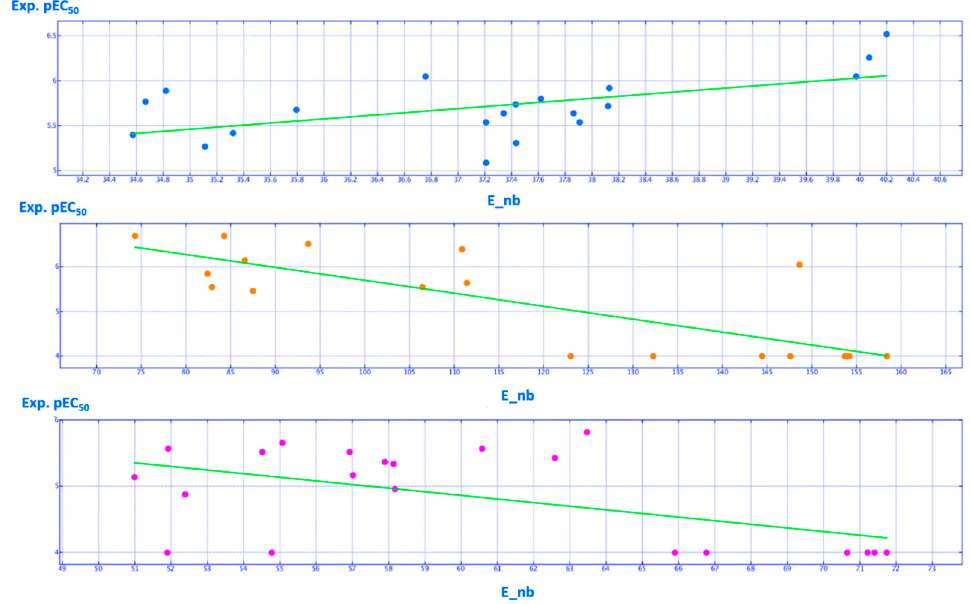
Figure 18. Distribution of the experimental (Exp.pEC 50 ) potency values of the training set compounds based on the E_nb descriptor (Kcal / mol). Hybrid derivatives, tetrahydropyridopyrimidines and cyanoquinolines are reported as cyan, orange and magenta spheres, respectively.